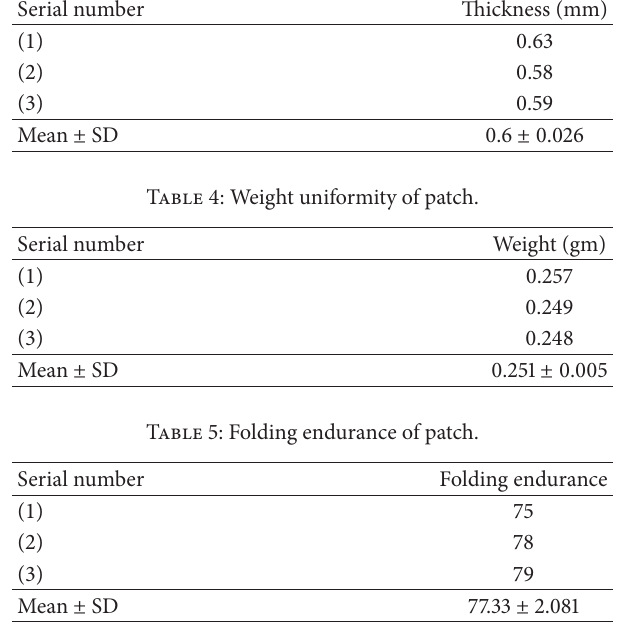
Table 6: Moisture content of patch.